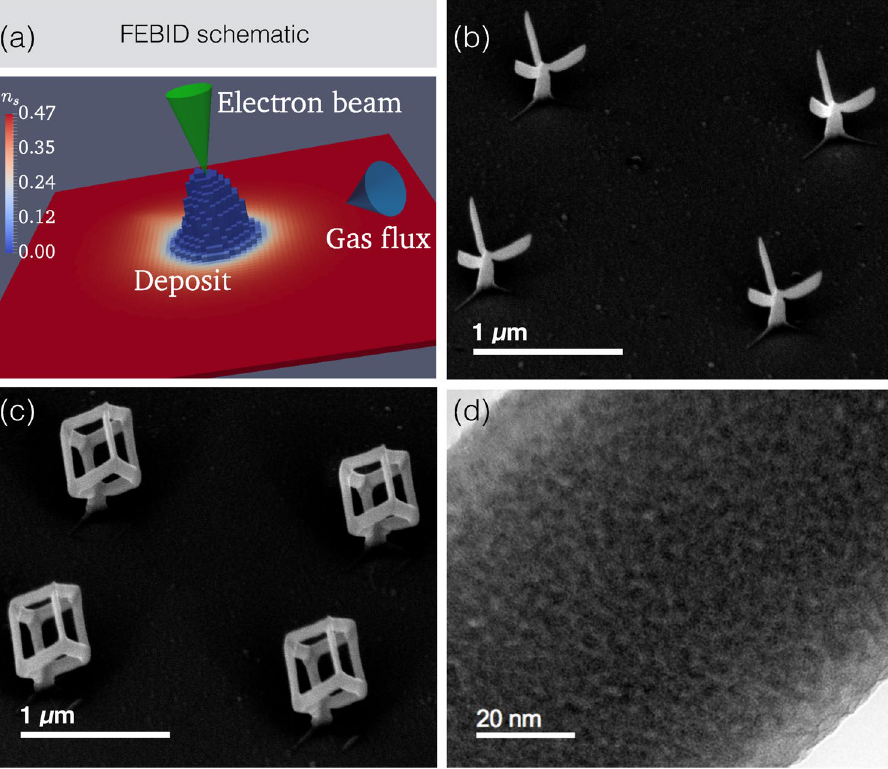
Figure 1. FEBID of 3D magnetic structures. ( a ) Schematic of FEBID process. n s denotes the precursor coverage normalized to a maximum of one monolayer. See methods section for details. ( b ) and ( c ) SEM images of 2 × 2 arrays of Fe-Co nano-trees ( b ) and nano-cubes ( c ). The geometrical dimensions of the nano-trees are about 119 nm stem diameter (cylindrical), stem length 185 nm, branch/edge diameters 80 and 64 nm (roughly elliptical) and branch/edge length 340 nm. The geometrical dimensions of the nano-cubes are about 119 nm stem diameter (cylindrical), stem length 90 nm, edge diameters 94 and 75 nm (roughly elliptical) and edge length 340 nm. ( d ) Transmission electron microscopy bright field image of nano-cube region demonstrating the nano-granular